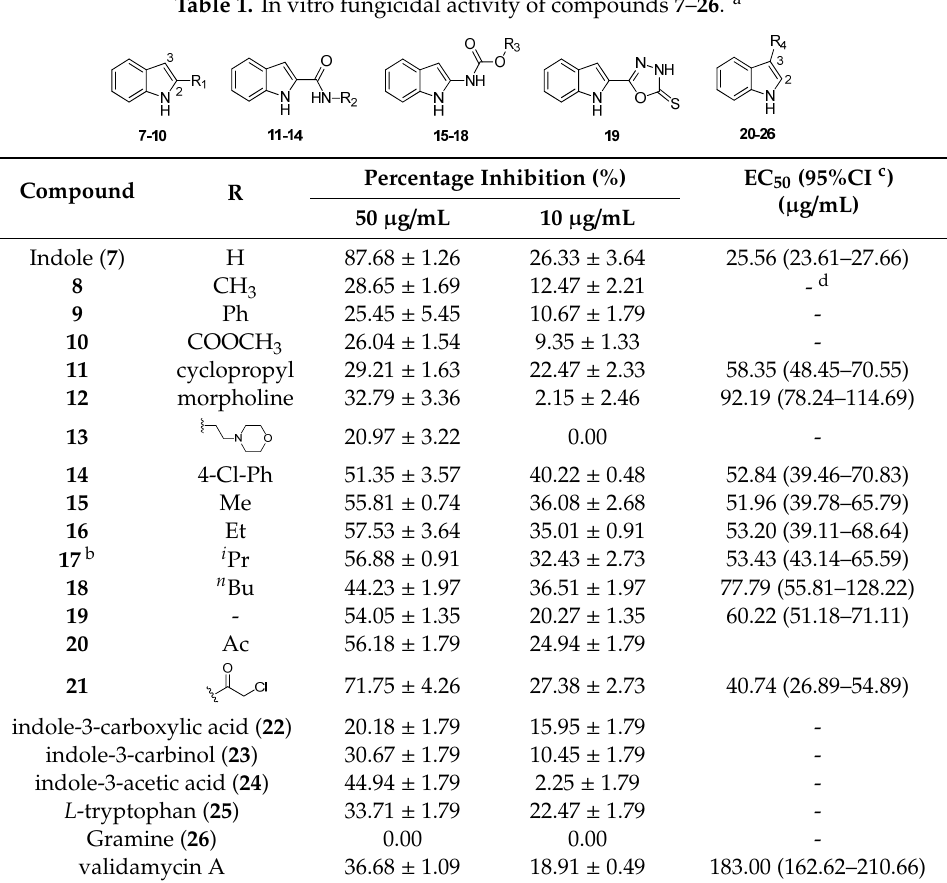
Table 1. In vitro fungicidal activity of compounds 7 – 26 . a.